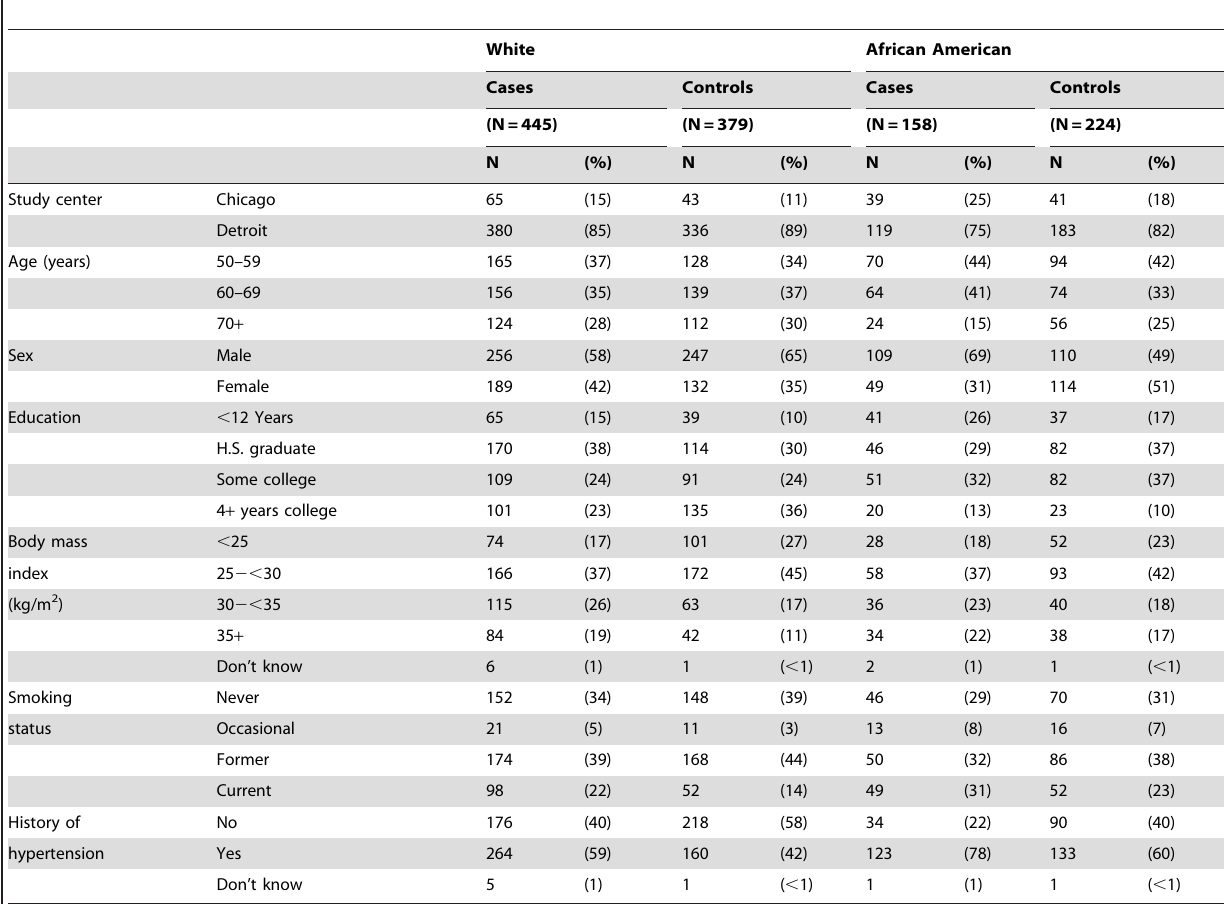
Table 1. Selected characteristics of cases and controls, by race, in the Kidney Cancer Study,